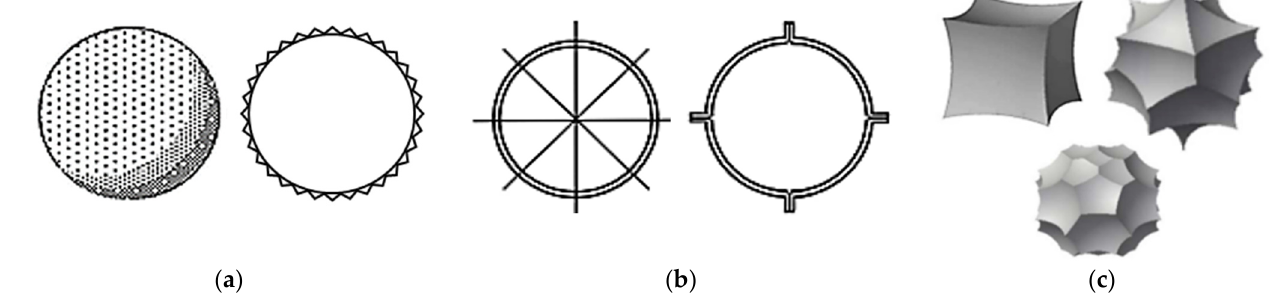
Figure 1. Different types of bubble aggregates: ( a ) Hollow spheres with surface treatment; ( b ) Rein- forced spheres; ( c ) Concave bubbles.